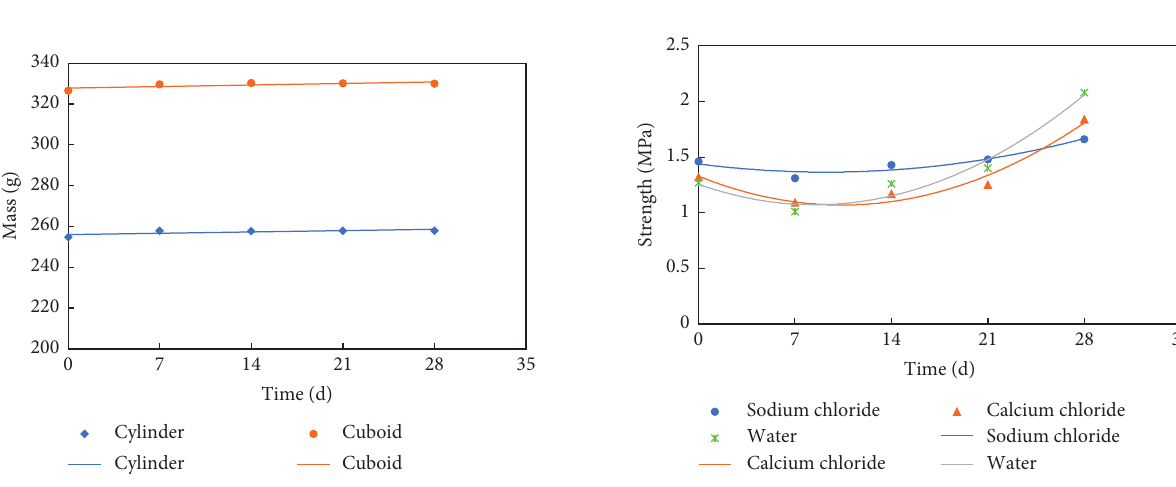
Figure 11: Mass changes of specimen with different shapes after erosion of NaCl solution of HWC materials.